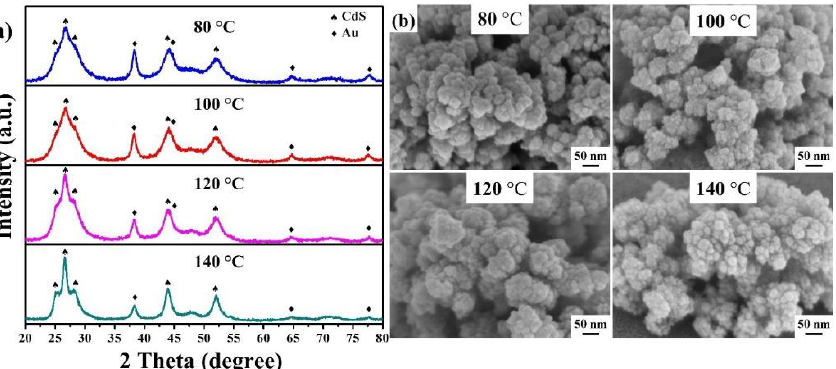
Figure 3. ( a ) XRD spectra and ( b ) FESEM images of Au@CdS nanocomposites were grown at different reaction temperatures. The reaction temperatures were 80, 100, 120, and 140 °C.